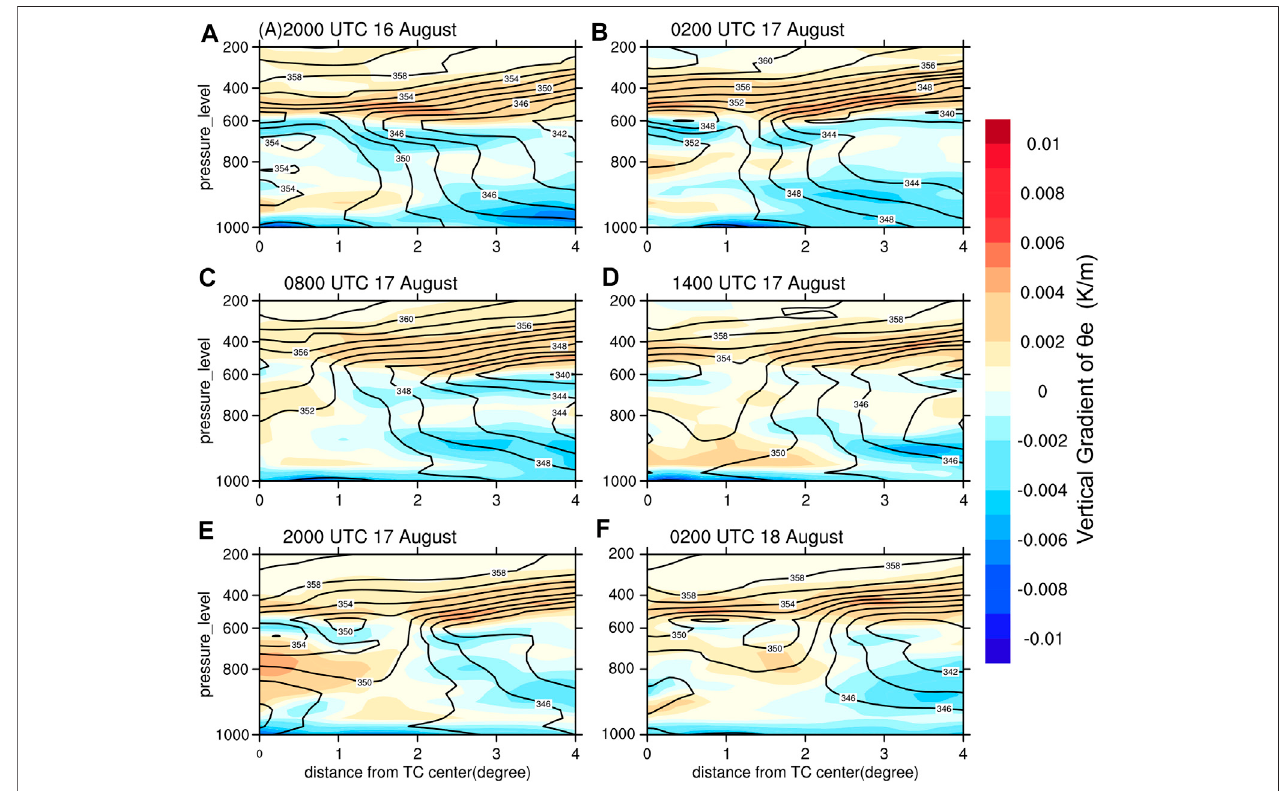
FIGURE 12 | Vertical-radius cross section of equivalent potential temperature (contours, K) and its vertical gradient ( z ϑ e/ z z) (shading, K/m). Both averaged in the northeast quadrant of the storm: (A) 2000 UTC 16 August, (B) 0200, (C) 0800, (D) 1,400, (E) 2000 UTC 17 August, (F) 0200 UTC August 18,